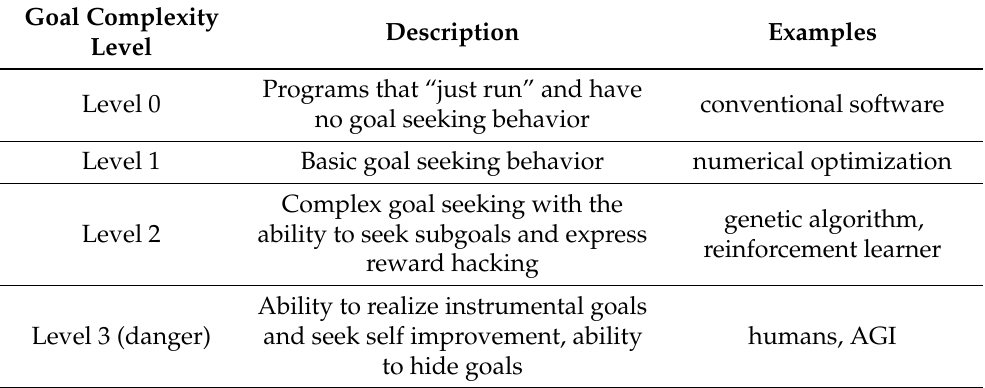
Table 6. AI goal complexity with